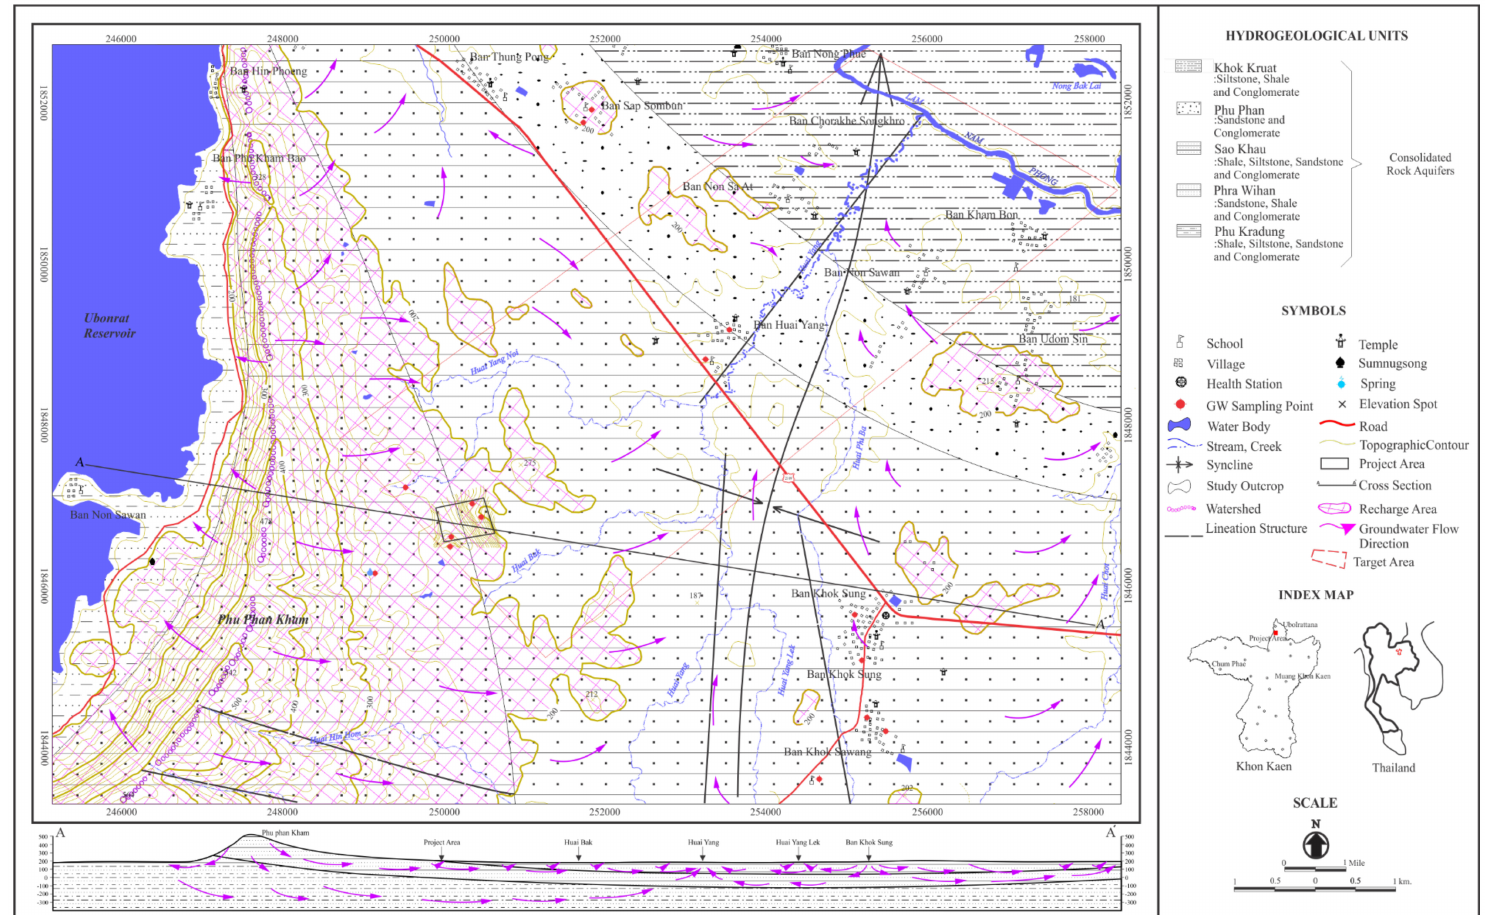
Figure 6. The hydrogeological map shows the direction of groundwater flow in the study area and adjacent area. The red quadrangle identified as the downstream area is the target site in this